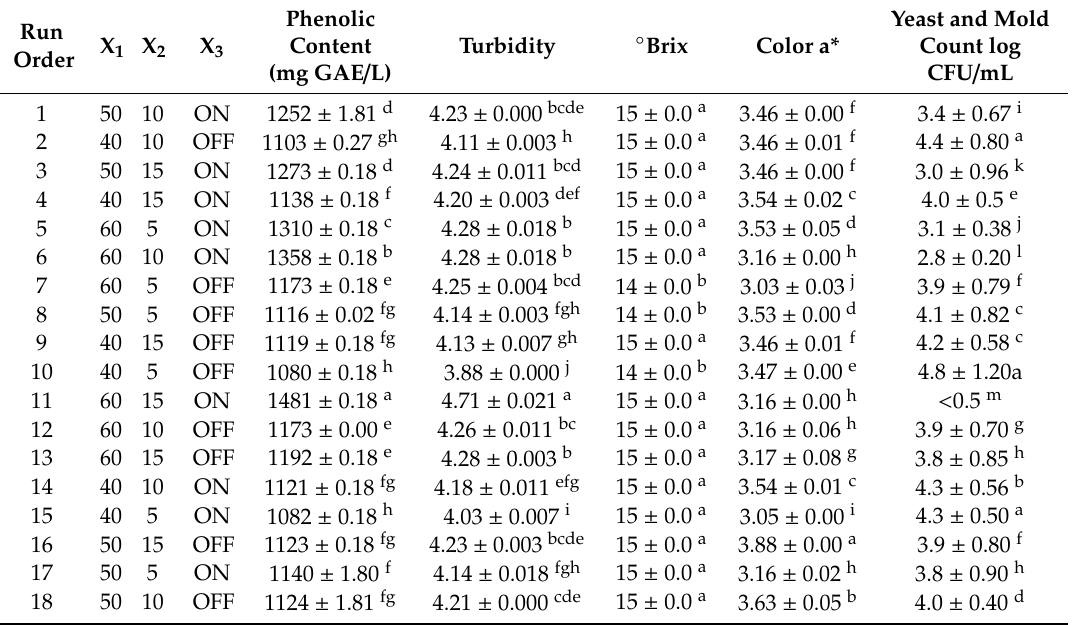
Table 4. Experimental parameters in the ultrasonic (US) treatment and the observed response values for pomegranate